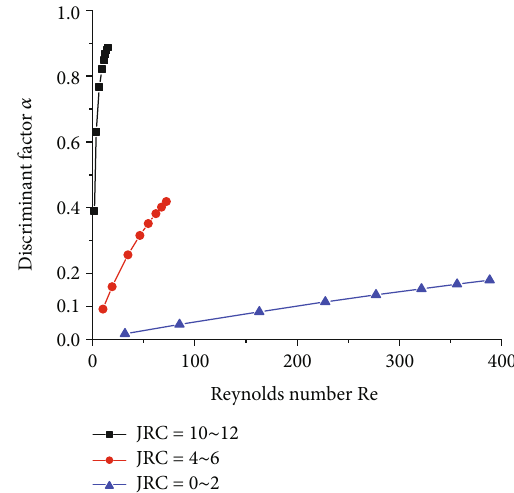
Figure 10: Relationship between discriminant factor α and the Reynolds number Re.